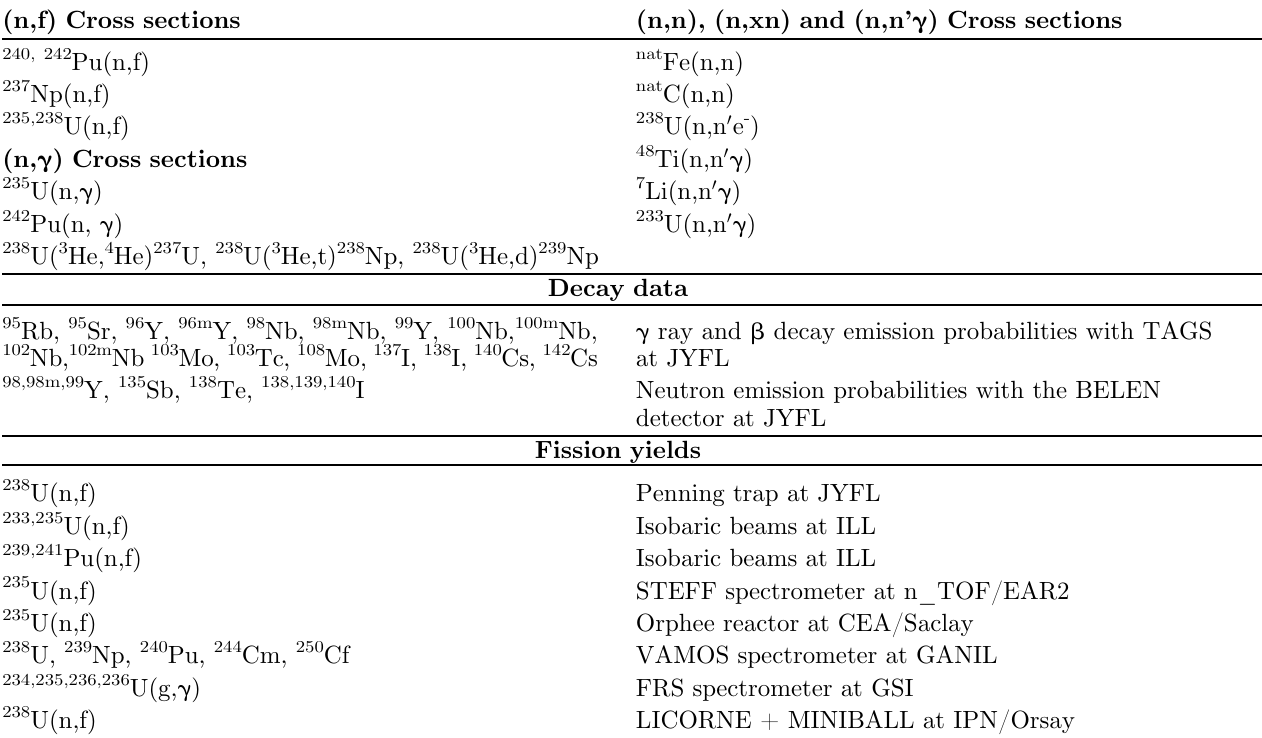
Table 1. Differential nuclear data measurements carried out within CHANDA. (n,f) Cross